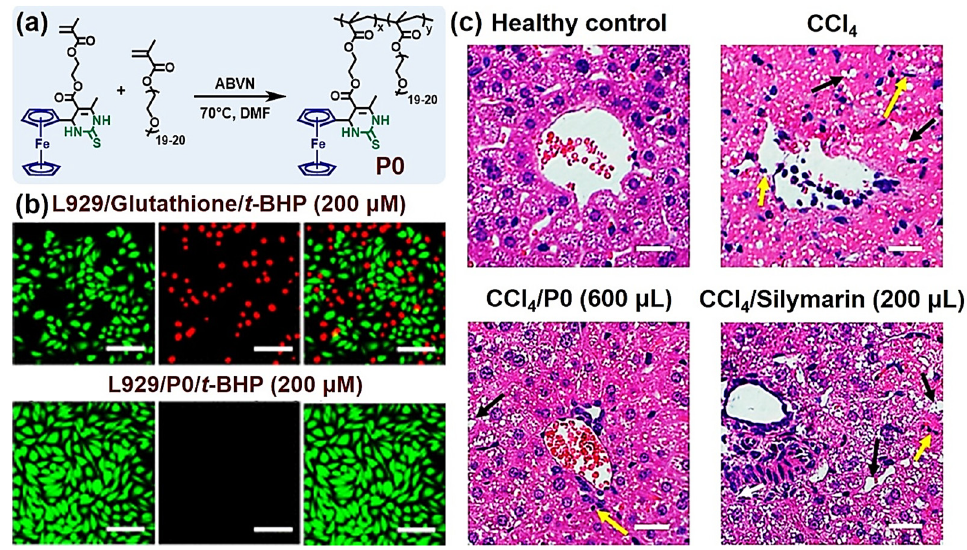
Figure 4. Antioxidant DHPMT–ferrocene polymer (P0) produced via the Biginelli reaction. ( a ) The synthesis of P0; ( b ) FDA/PI double-staining of L929 cells in t -BHP + glutathione (200 µM, up ) and t -BHP + P0 (200 µM, down ); scale bar = 100 µm; ( c ) Histological images of liver sections from healthy control group ( top left ), no additional treatment group ( top right ), CCl 4 /P0 group (600 µL, 20 mg/mL, intravenous tail injection, bottom left ), and CCl 4 /Silymarin group (200 µL, 20 mg/mL, intraperitoneal injection, bottom right ); black arrows for vacuoles and yellow arrows for inflamed cells, and scale bar = 20 µm. Reprinted with permission from ref. [58] . Copyright © 2019 American